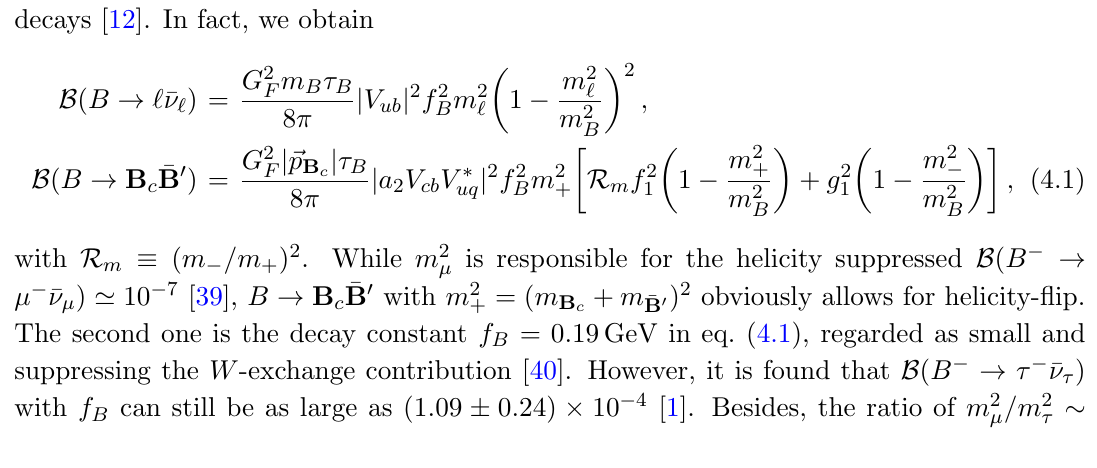
W -exchange contribution to